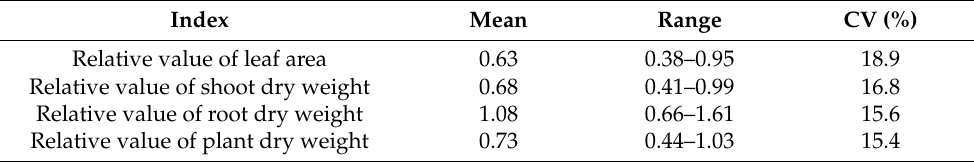
Table 1. Range of relative values of growth characteristics in pepper seedlings.